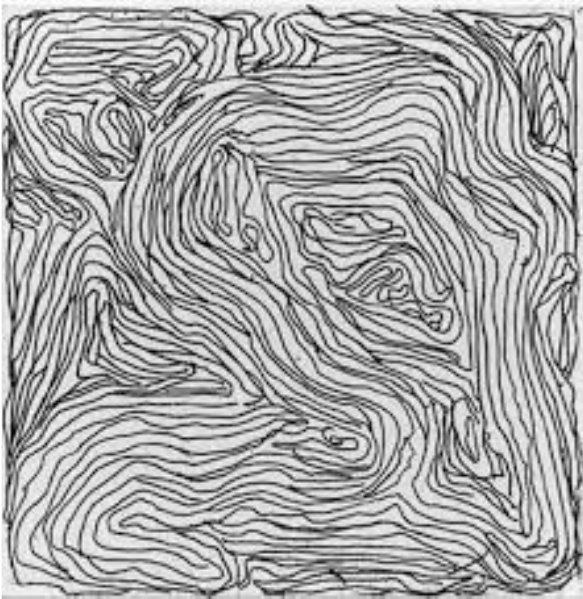
Figure 5 | Sol LeWitt, Small etching / black and white no. 7, 1999.